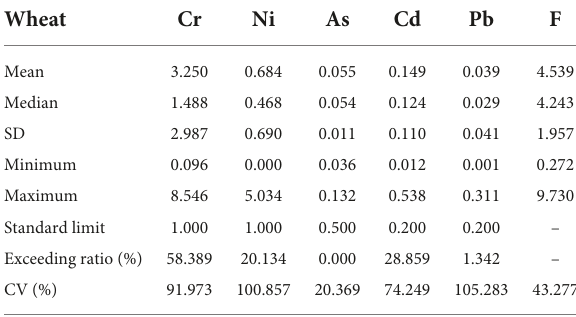
TABLE 1 The descriptive statistics of PTE concentrations in wheat grains